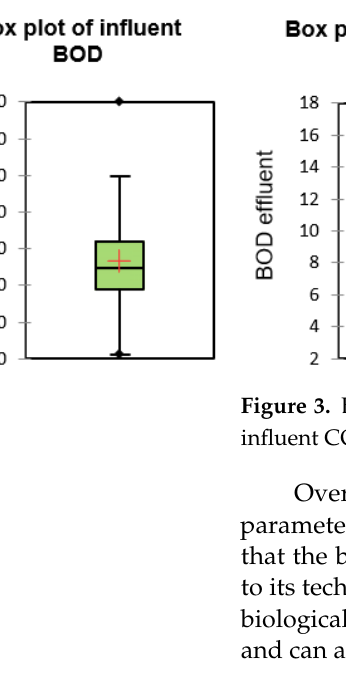
Figure 3. Boxplots of the wastewater parameters; from left to right: influent BOD, effluent BOD, influent COD, and effluent COD.